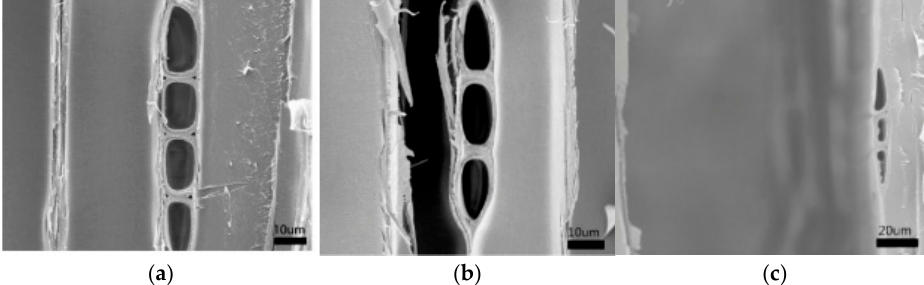
Figure 9. Cracks in the samples under the following conditions: ( a ) control, ( b ) low intensity, and ( c ) high intensity, according to [19].